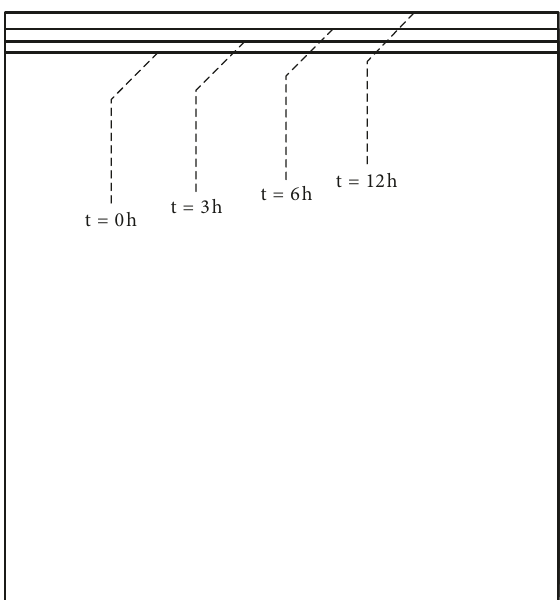
Figure 10: Evolution of the coal volume with time under the effect of